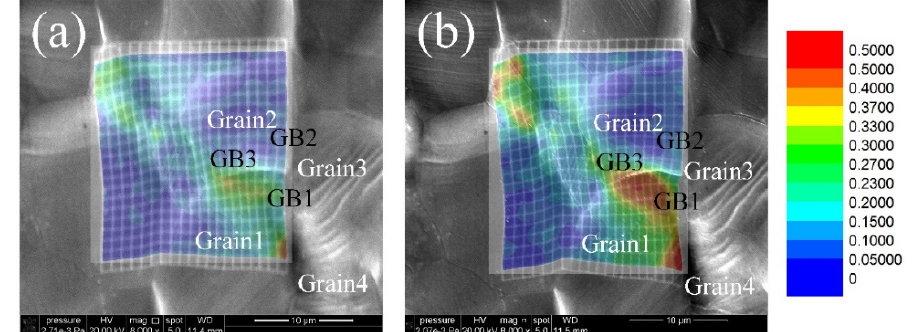
Figure 5. ( a ) Strain map after 0.1 tension strain and ( b ) strain map after 0.15 tension strain. Table 1. Schmid factors of basal slip systems and prismatic slip systems in Grains